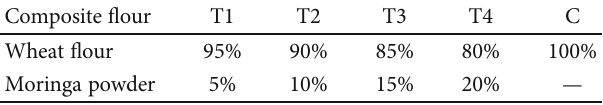
Table 1: Formulation of wheat fl our and moringa leaf